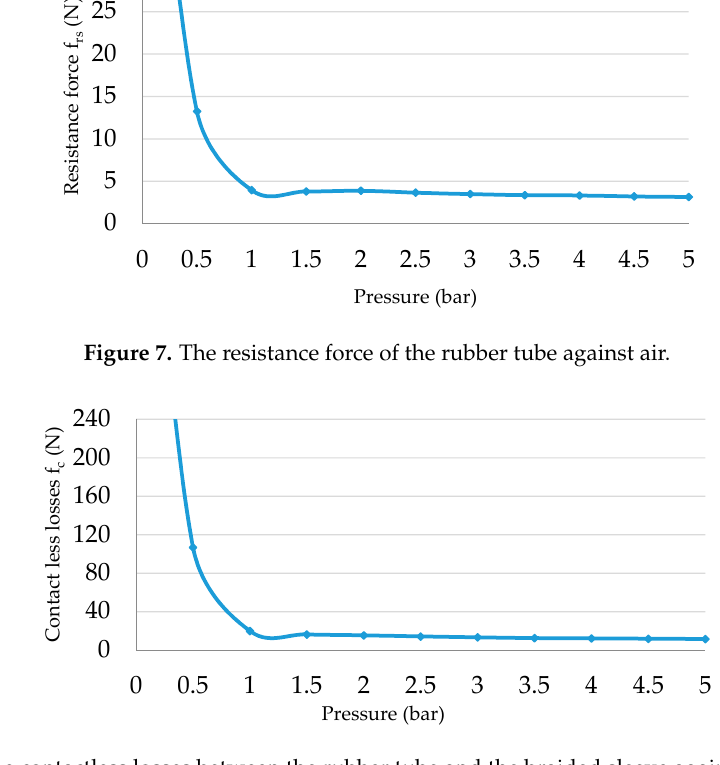
Figure 8. The contactless losses between the rubber tube and the braided sleeve against air pressure.